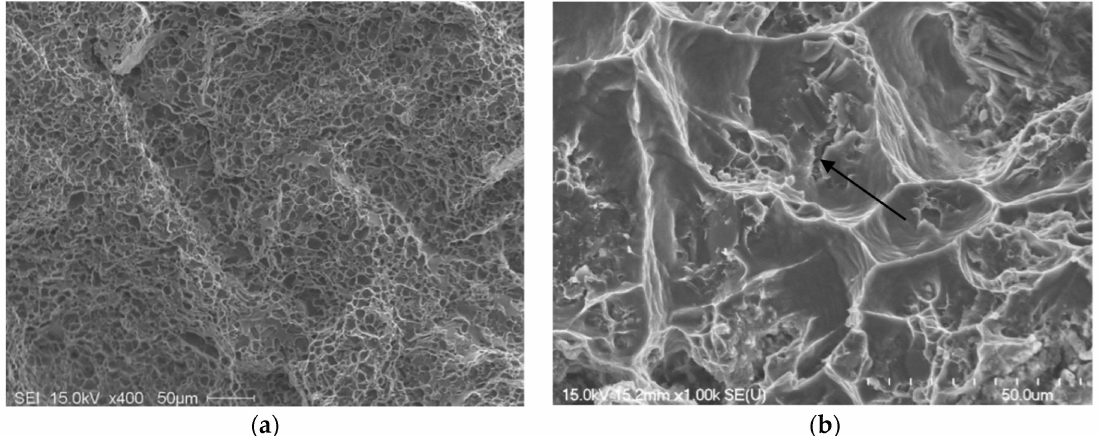
Figure 14. Fracture surface of A1BS alloy: ( a ) as cast contion; ( b ) after solutionizing at 540 ˝ C for 12 h, DAS ~ 25 µ m; the arrow in ( b ) refers to central cracks from failed Si